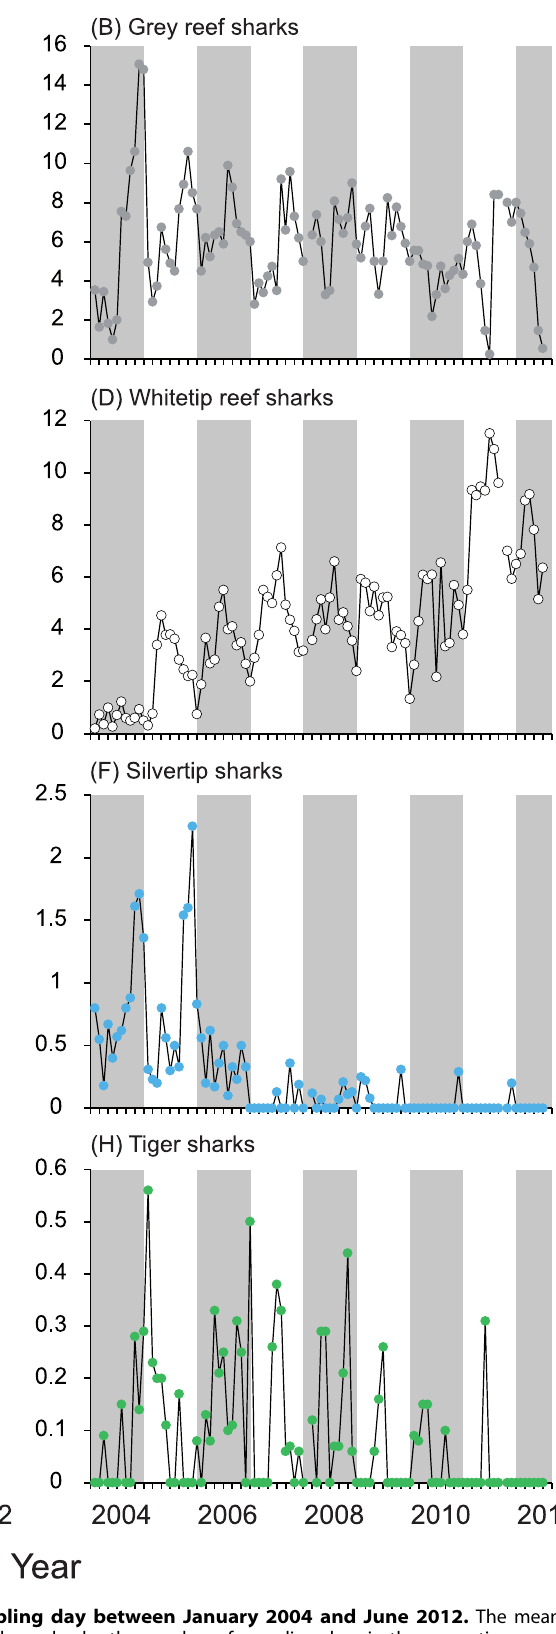
PLOS ONE | www.plosone.org